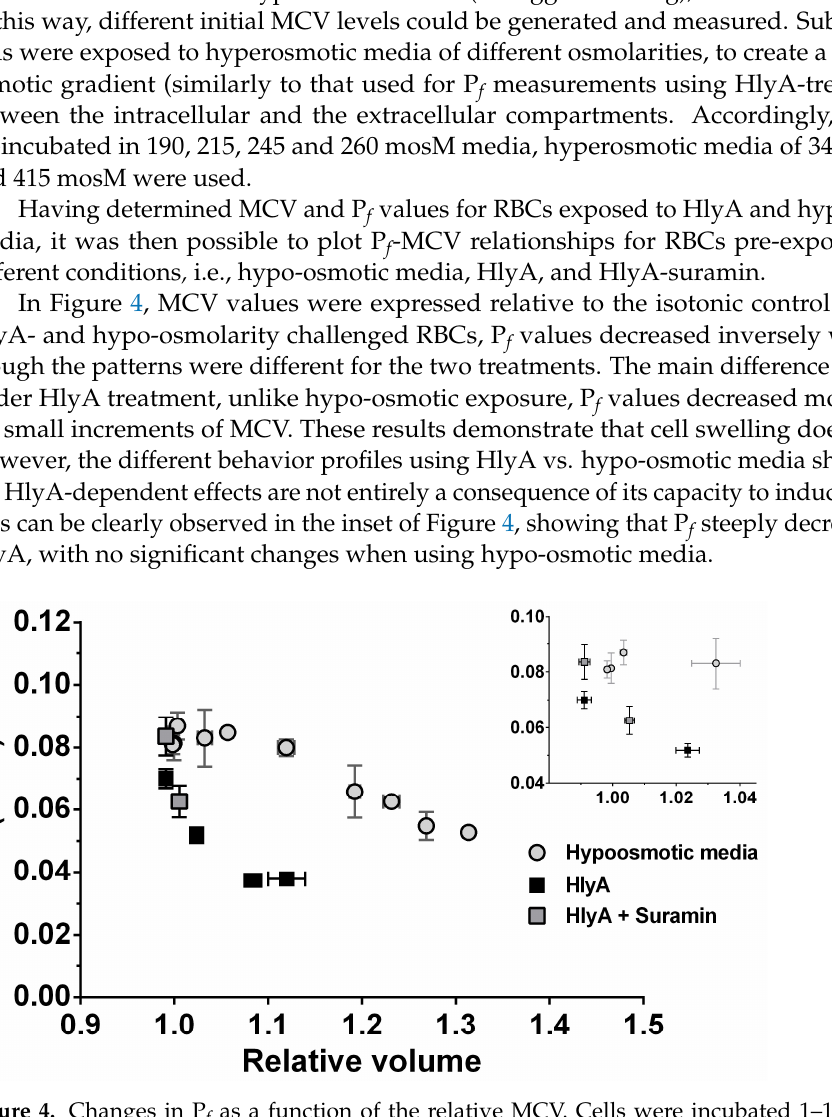
Figure 4. Changes in P f as a function of the relative MCV. Cells were incubated 1–10 min with 100 ng/mL HlyA in the presence of 100 µ M suramin (gray square) or in its absence (black square), or were exposed to hypo-osmotic media (190–260 mosM, grey circles). After incubation, different aliquots of RBCs suspensions at 10% hematocrit were used to determine MCV, and to perform stopped-flow experiments, as described in Section 4.7. P f values were calculated as described in Section 4.8. The relative MCV was calculated by dividing the measured MCV by the MCV of control RBCs in isosmotic medium. For the preparation of this figure, the results were grouped in 8 groups based on the measured relative volume ranges (0.95–1, 1–1.05, 1.05–1.1, 1.11–1.15, 1.15–1.2, 1.2–1.25, 1.25–1.3, 1.3–1.35 relative volume). Then relative cell volumes and P f values within each range were averaged. Inset: Magnification of the main plot between 0.95–1.04 relative volume. Results are means ± S.E.M. (Hypo-osmotic media, N = 5; HlyA, N = 8, HlyA and Suramin, N = 4). Thus, HlyA affects P f by volume-dependent and volume-independent